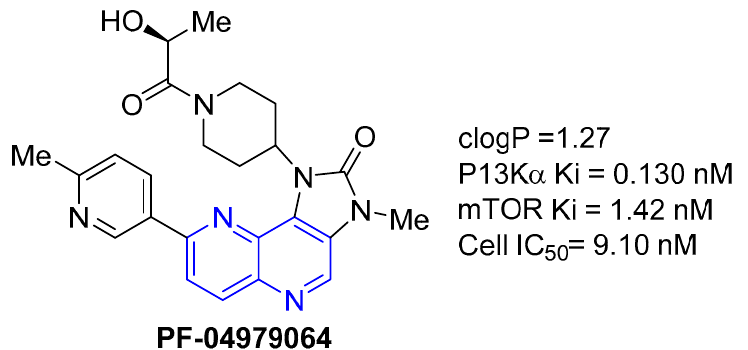
Figure 14. PI3K / mTOR dual kinase inhibition of Figure 14. PI3K/mTOR dual kinase inhibition of PF-04979064. Figure 14. PI3K/mTOR dual kinase inhibition of PF-04979064.